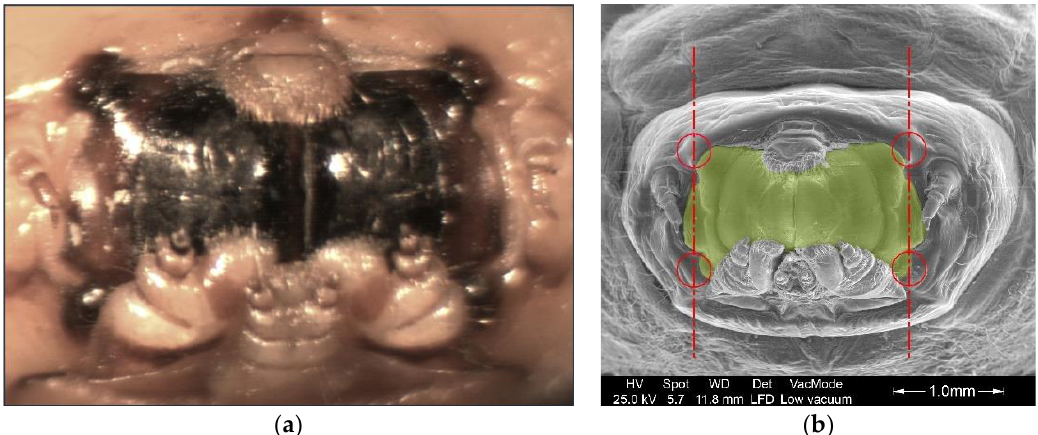
Figure 5. Mouthparts of the larva: ( a ) Optical microphotography of the mandible; ( b ) electron micrograph of the cephalic capsule. The mandibles are highlighted in green; the joints and axis of rotation are highlighted in red.